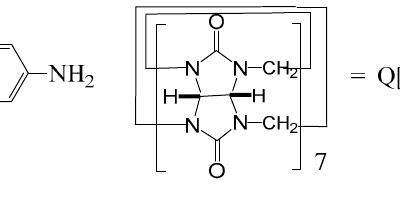
Figure 1. The structures of MDA, AN, and Q[7].